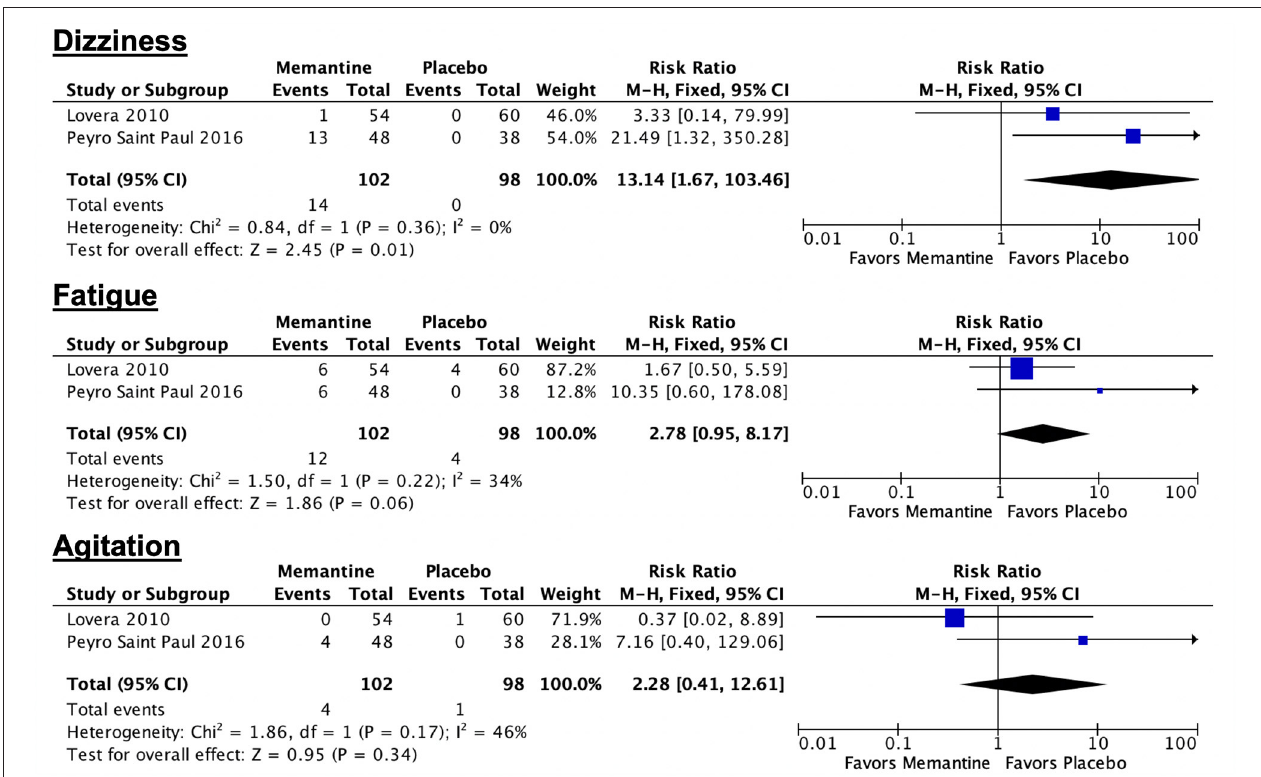
FIGURE 4 | Forest plot summarizing combinable adverse drug effects from two